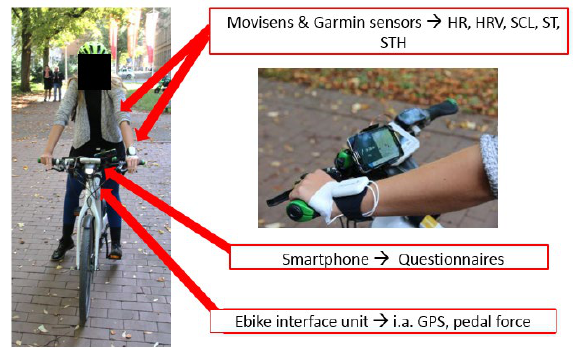
Figure 2. Proband with measurement